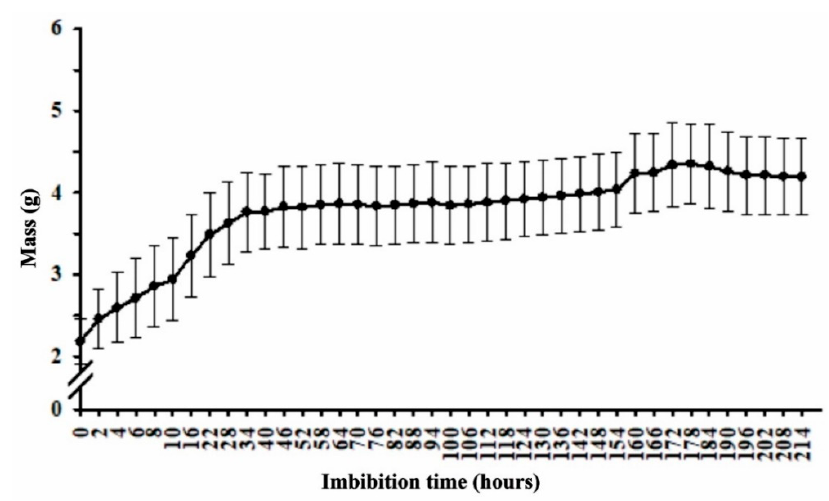
Figure 1. Pterodon pubescens seed mass gain as a function of imbibition time. Table 1. Luminosity (L), color index “a” (a), color index “b” (b), chroma (Cr) and hue color angle ( ◦ h) in Pterodon pubescens seeds, subjectively categorized into different integument color